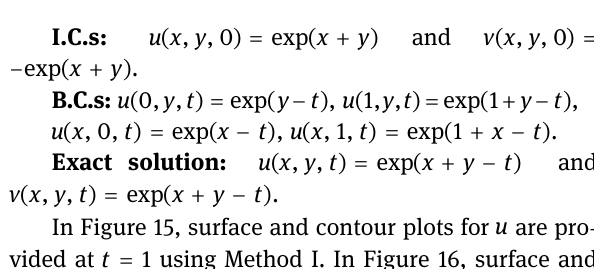
t 1 = . In Table 19, L u 2 and L u are compared with [ 8 ] ∞ using Methods I and II. Methods I and II have generated better results at some points. In Table 20, L u 2 and L u are ∞ matched with [ 8 ] using Methods I and II. Methods I and II have produced the acceptable results in most of the cases. In Table 21, relative errors of u are better matched with [ 8 ] and [ 18 ] using Methods I and II. In Table 22, relative errors of u are compared with [ 8 ] and [ 18 ] using Methods I and II.